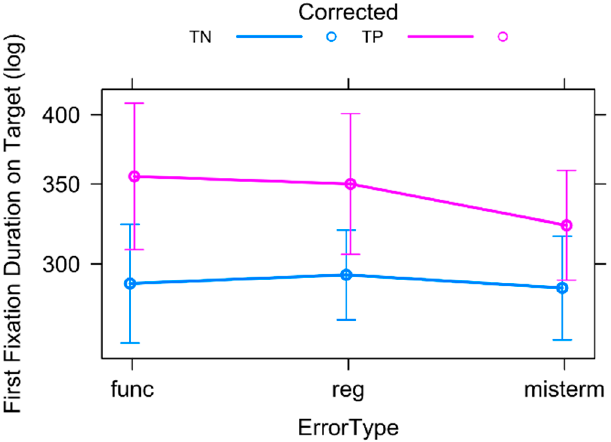
Figure 17. Interaction effect of Corrected and Error Type on first fixation duration on target text.